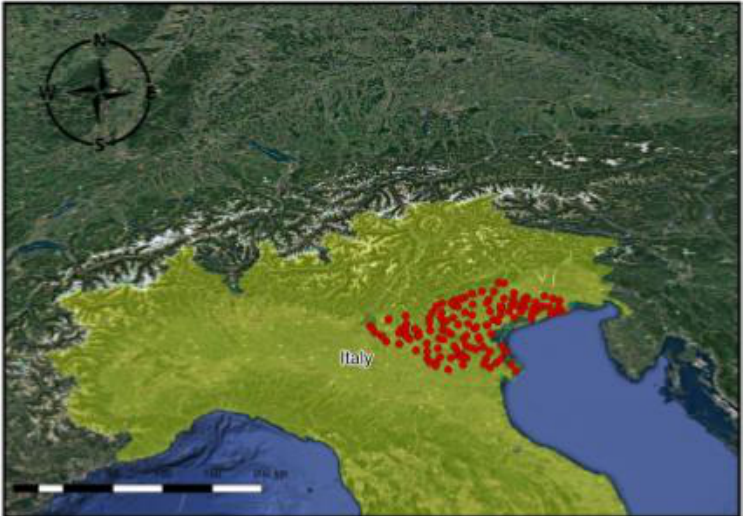
Figure 1. Veneto region in Northeast Italy (Top left: 10.62, 45.81 Bottom right: 13.08, 44.94, Da- tum WGS84). The entomological monitoring network of 140 traps of the Culex pipiens in the Veneto